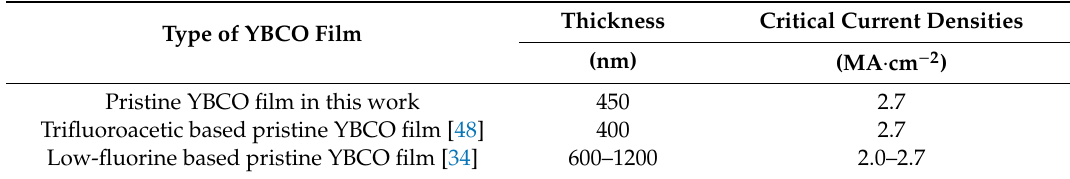
Table 2. Comparison of several pristine YBCO films with their thickness and critical current densities obtained via the ink-jet printing methods found in the